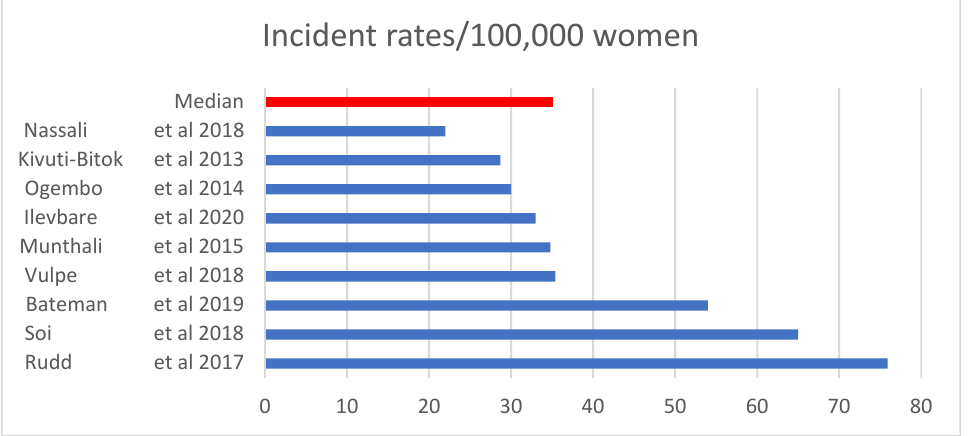
Figure 2. Cervical cancer incidence. Sources: [8,11,38–42]. Cervical cancer mortality rates were reported by 7 studies whose values ranged from 17.5 to 49.8 per 100,000 women with a median of 36.0 per 100,000, as displayed in Figure 3.